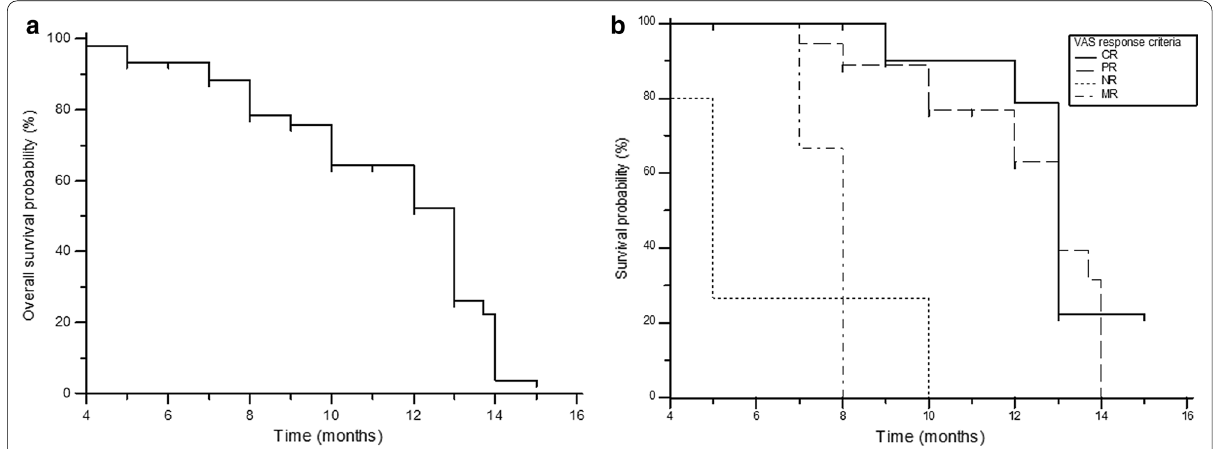
Fig. 4 a Kaplan–Meier analysis: overall survival. b Overall survival, according to the response category as per VAS response